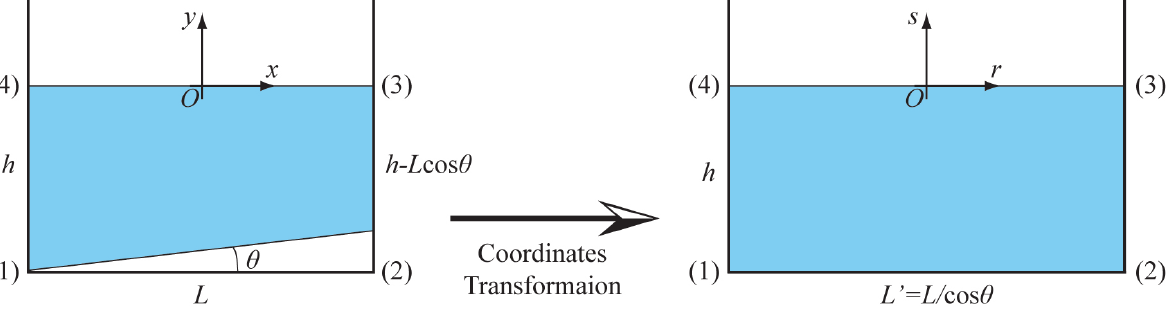
Figure 2. Scheme of the coordinate transformation for the study of the Laplace equation in a sloped bottom